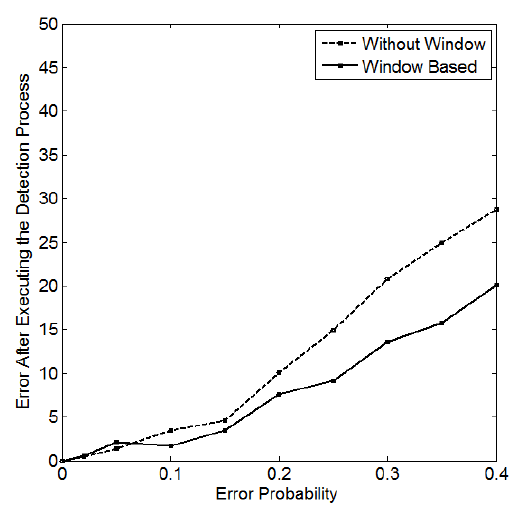
Figure 10. Comparison of With and Without Sliding Window On Probability of Errors after Executing the Detection